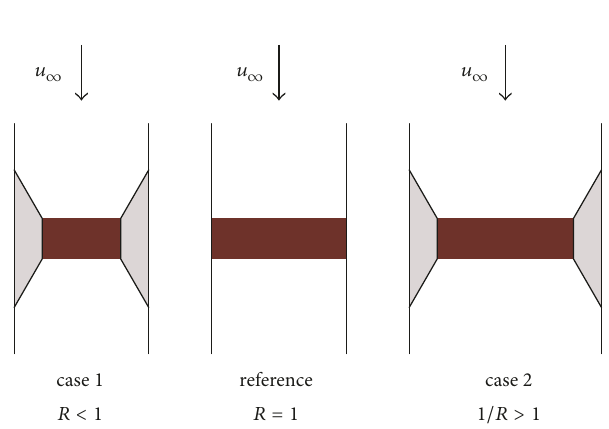
Figure 8: The optimum velocity ratio 𝑢 a function of the static drop coefficient 𝐾 in a device for which 𝐴 also shown; the area highlighted in red, where the hydraulic power is positive (i.e., received by the water) is merely of theoretical interest. This diagram presents the solutions to (24) in which (25) is inserted, when 𝑅 = 1 .